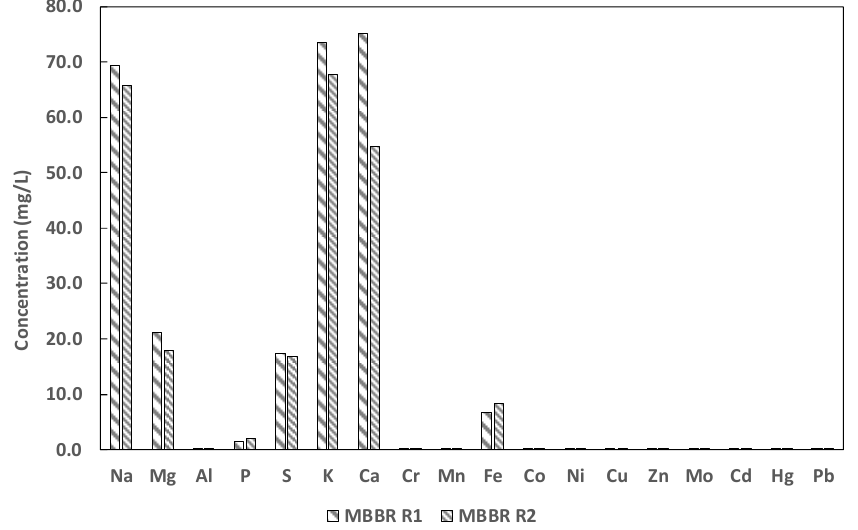
Figure 5. The major metallic and non-metallic element concentrations in the reject water from MBBR R1 and MBBR R2.